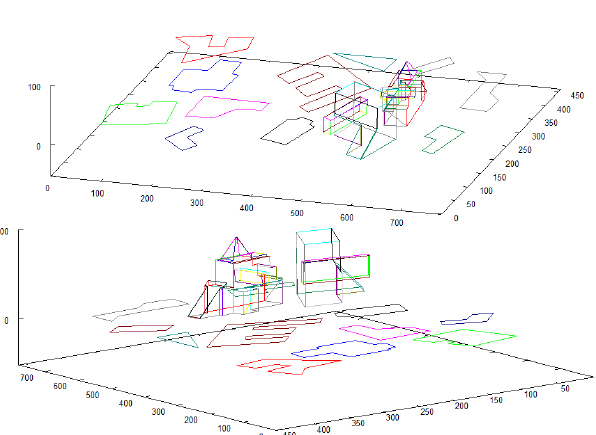
Figure 17. 2D model of terrain, enriched with 3D models of objects that were previously